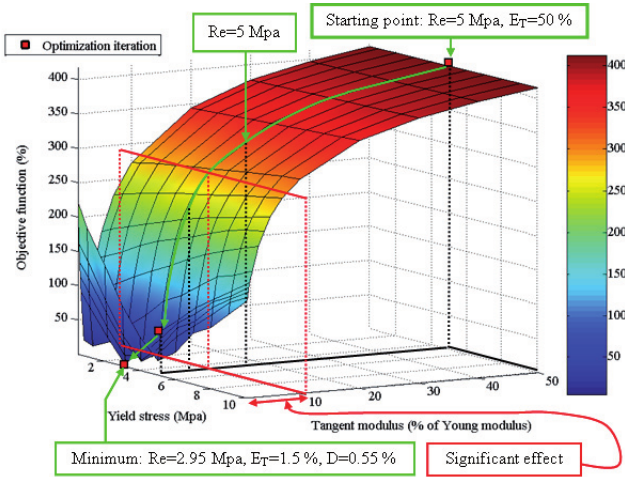
Fig. 7. Objective function versus design